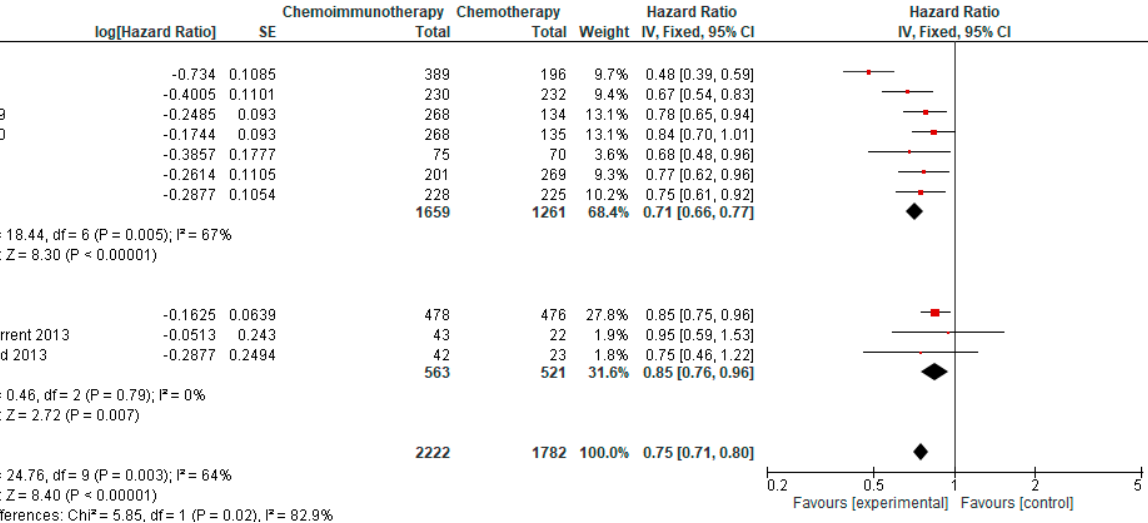
Figure 1. Forest Plot of hazard ratios for progression-free survival of patients with ES-SCLC and treated with chemo-ICI versus standard chemotherapy. PD–1/PD–L1, programmed death (ligand)–1; CTLA–4, cytotoxic T-lymphocyte-associated protein 4; HR, hazard ratio; CI, confidence interval; IV, inverse variance.